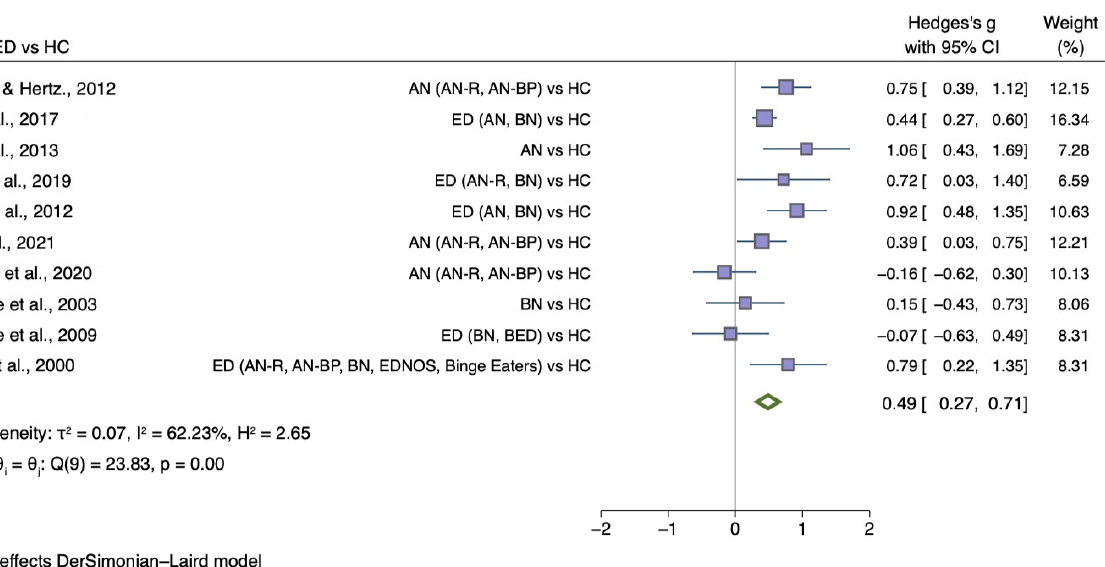
Figure 3. Forest plots of Hedges’ g in generic disgust sensitivity between ED participants and HCs from n = 10 studies; CI: confidence interval. Refs.